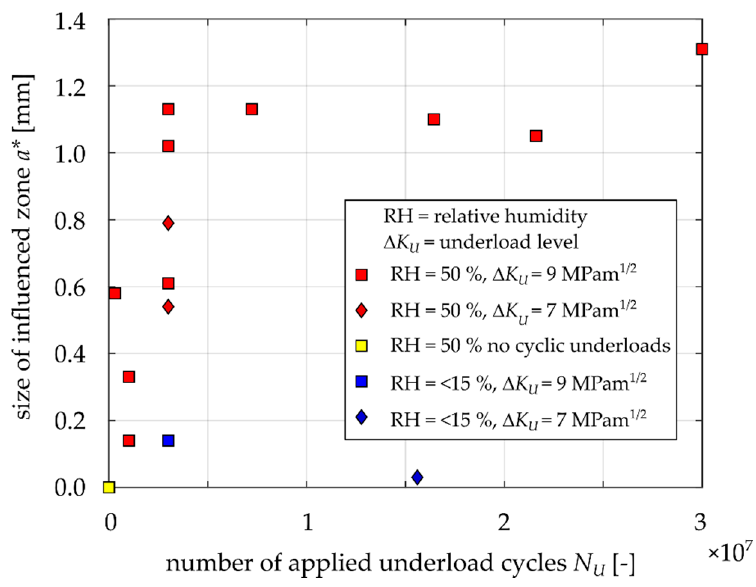
Figure 12. Experimentally obtained influenced zones a * after underloads.